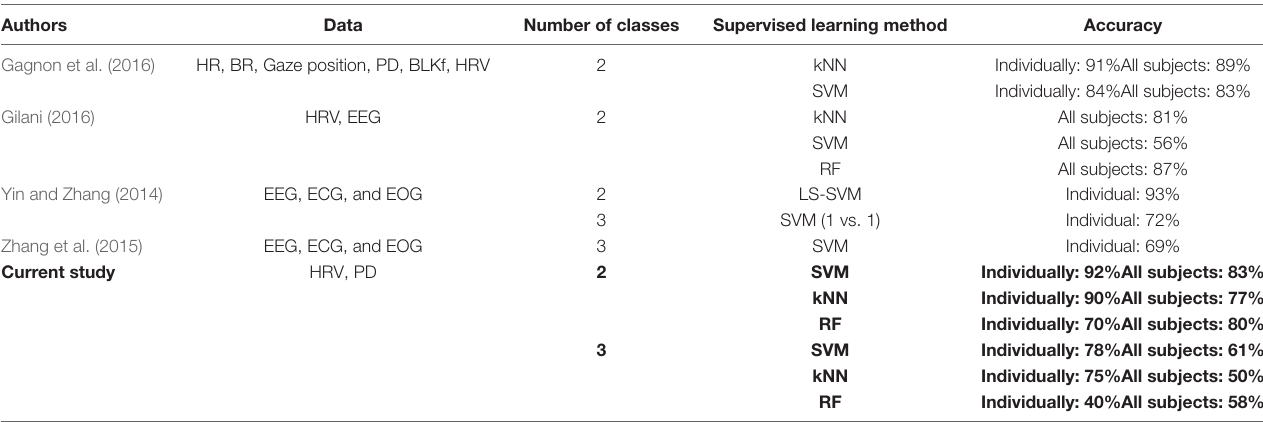
TABLE 6 | Comparison between the present study and literature works for 2-class and 3-class OFS classification.